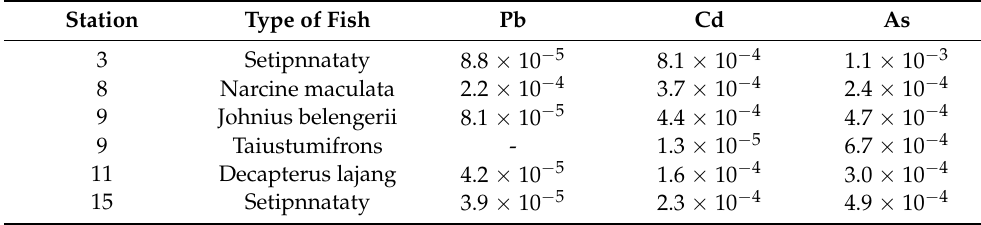
Table 11. Carcinogenic risks (CR) of heavy metals in fishes ( n = 6) obtained from Haikou Bay and adjacent waters Unit: